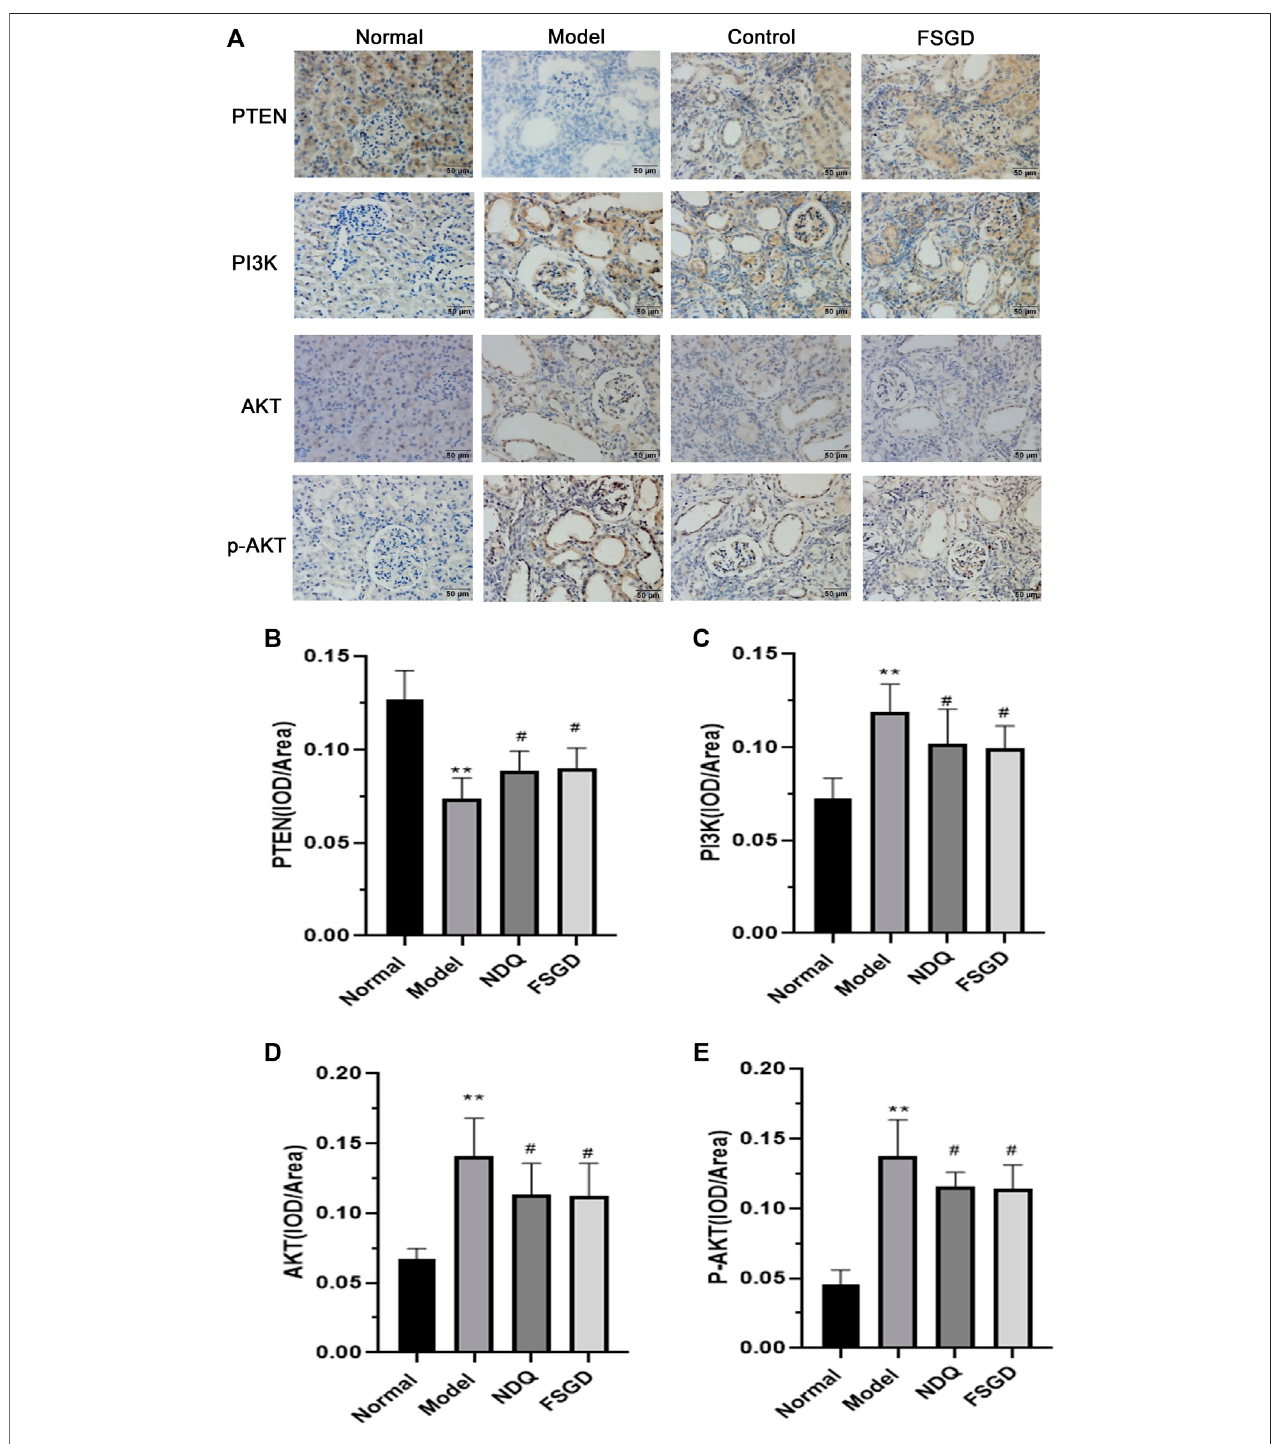
FIGURE 6 | Effects of FSGD on PI3K/AKT pathway by immunohistochemistry. (A) The immunohistochemistry staining of PI3K/AKT pathway. (B – E) Image- ProPlussoftwarewas used tostatisticallyanalyzetheimmunohistochemical staining resultsofPTEN, PI3K, AKT and p-AKT, respectively. Thedataareexpressed as: compared with the normal group; * p < 0.05, ** p < 0.01; versus normal group; ## p < 0.01, # p < 0.05, compared with the model group, respectively.